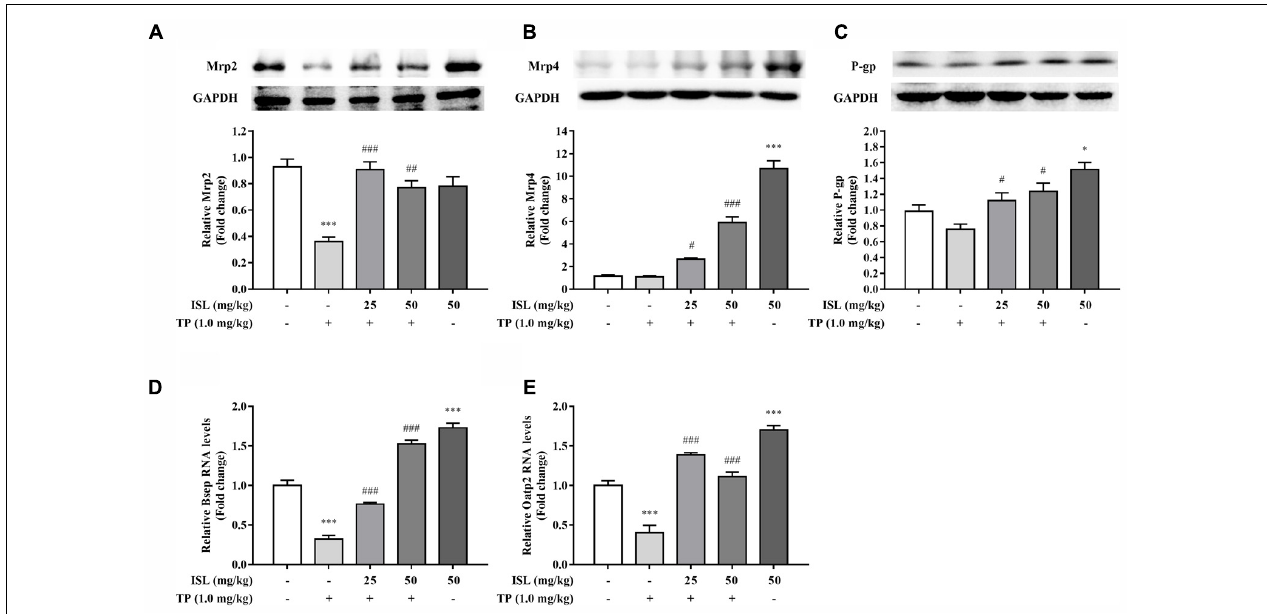
FIGURE 6 | Effects of TP, ISL, or ISL + TP on the protein levels of (A) MRP2, (B) MRP4, and (C) P-gp and the mRNA levels of (D) Bsep and (E) Oatp2 in mouse livers. Cell lysates were analyzed by Western blot and mRNAs by RT-PCR. Data were presented as means ± SE ( n = 5); ∗ P < 0.05 vs. the control group, ∗∗∗ P < 0.001 vs. the control group, # P < 0.05 vs. the TP group, and ### P < 0.001 vs. the TP